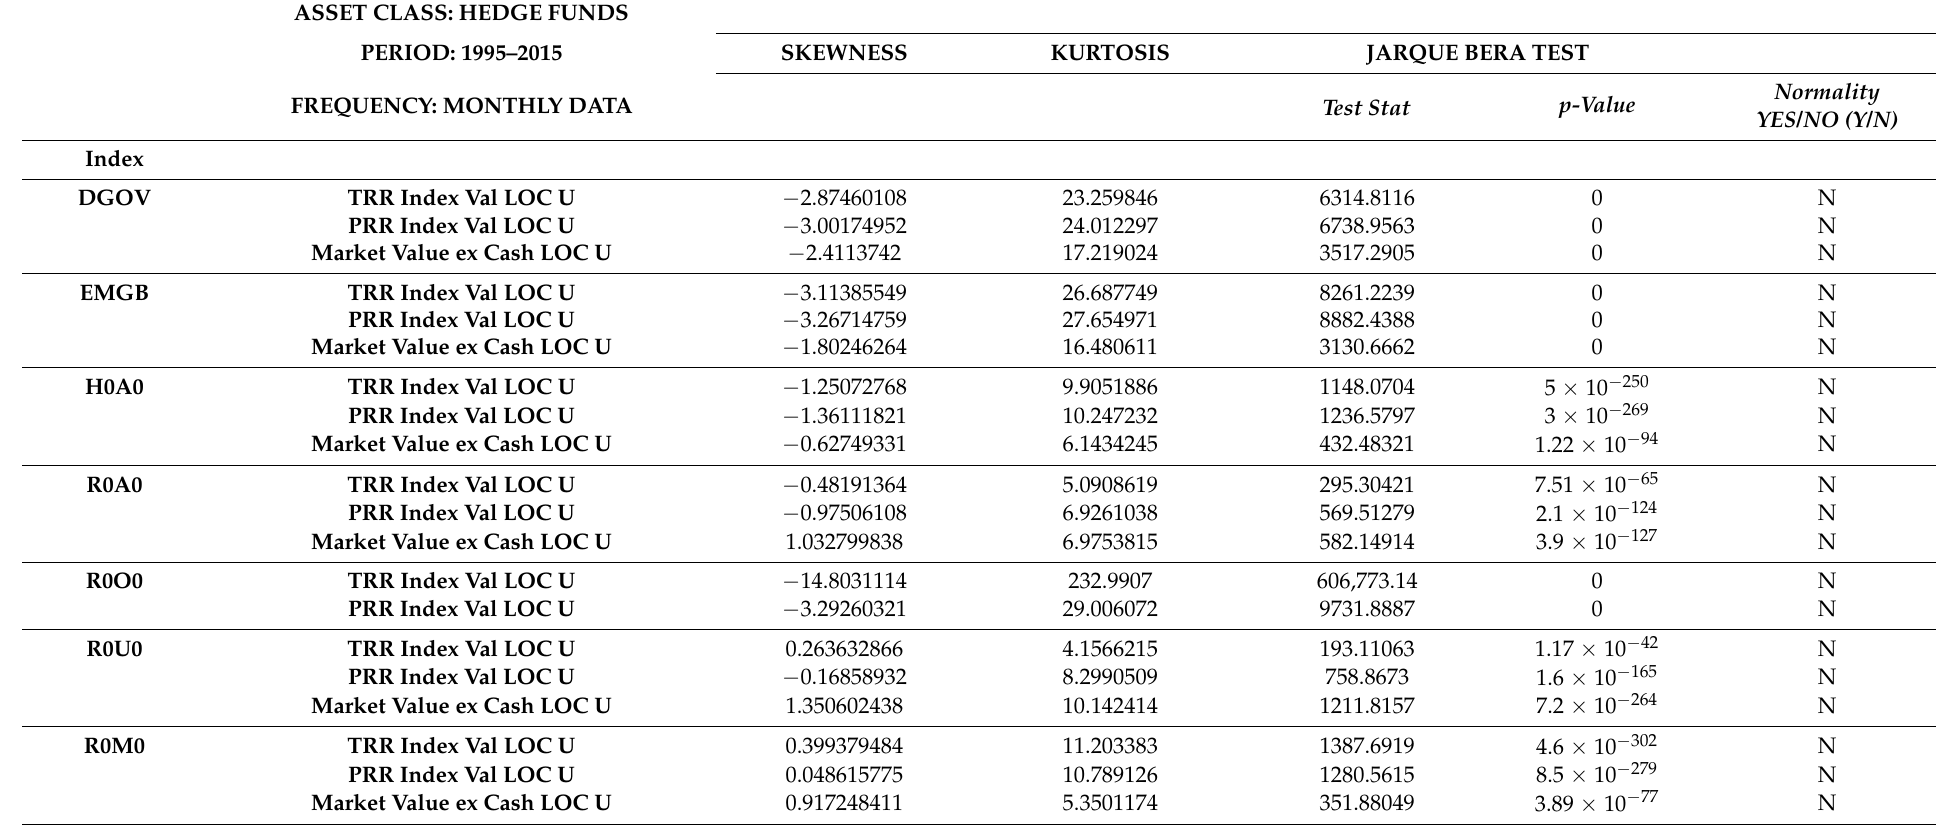
Table A3. Jarque Bera Test On Global Bond Indices Data